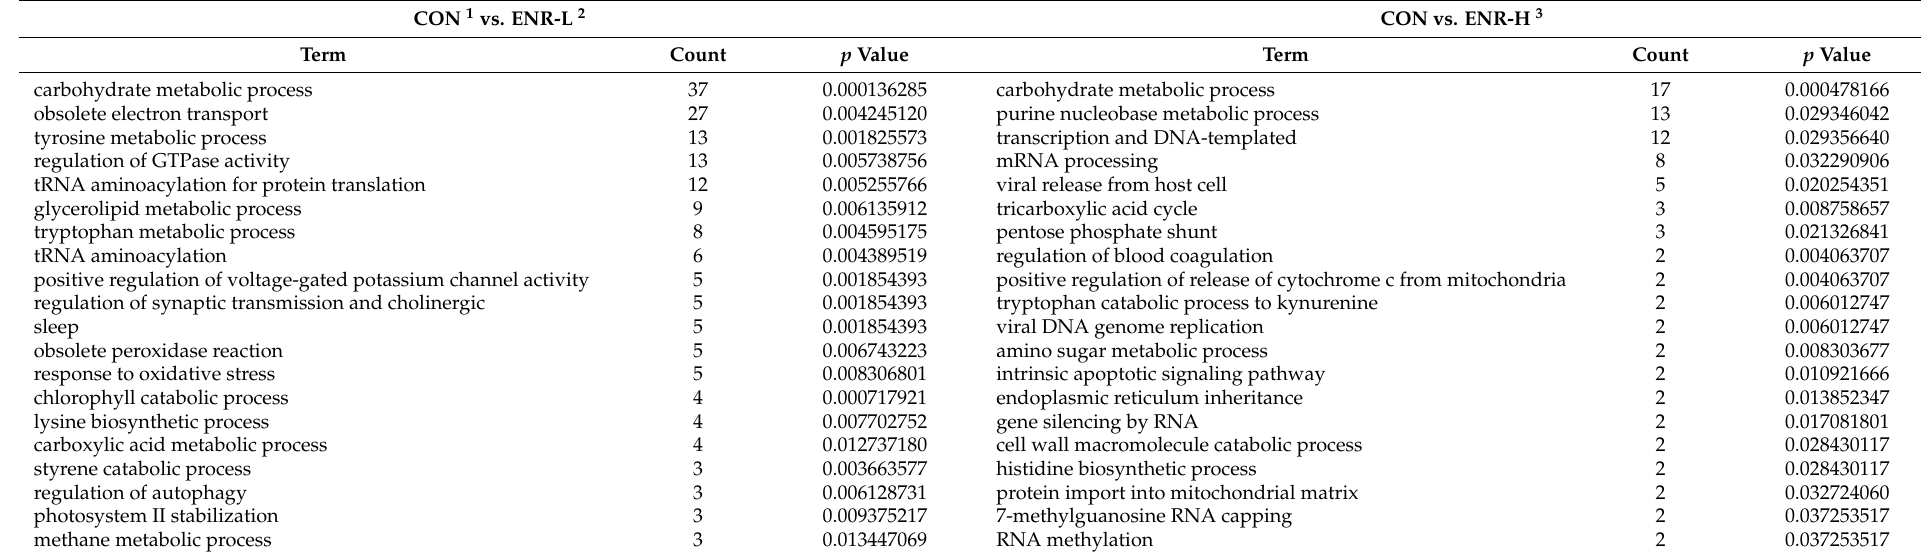
Table 1. The top 20 biological processes (BP) in gene ontology (GO) analysis of differentially expressed genes (DEGs). CON 1 vs. ENR-L